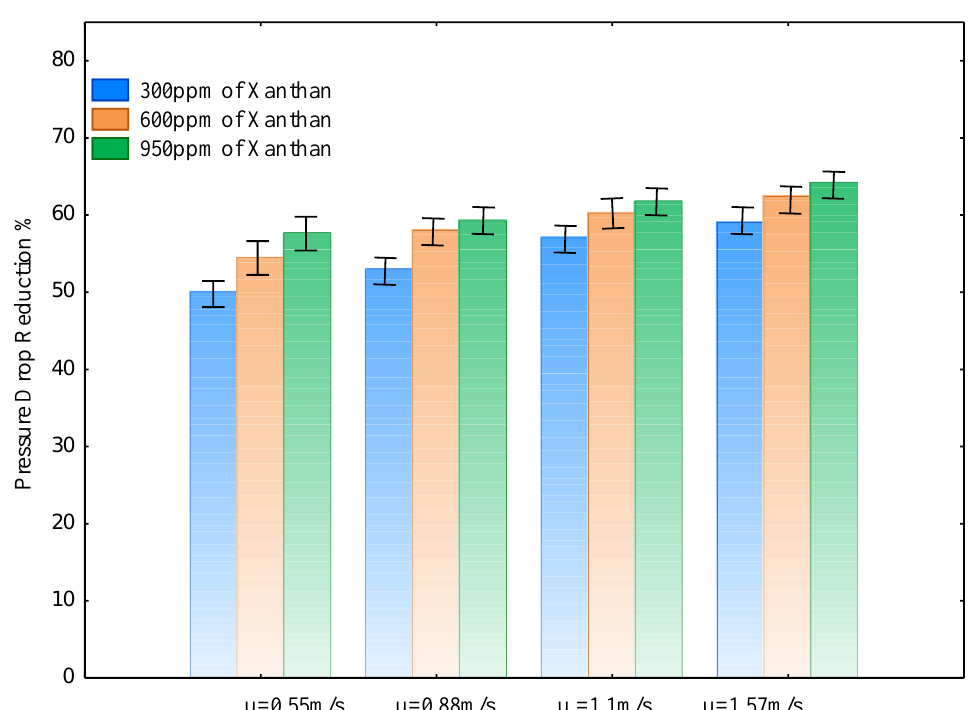
Figure 6. The pressure drop reduction with different xanthan concentrations and water velocities.